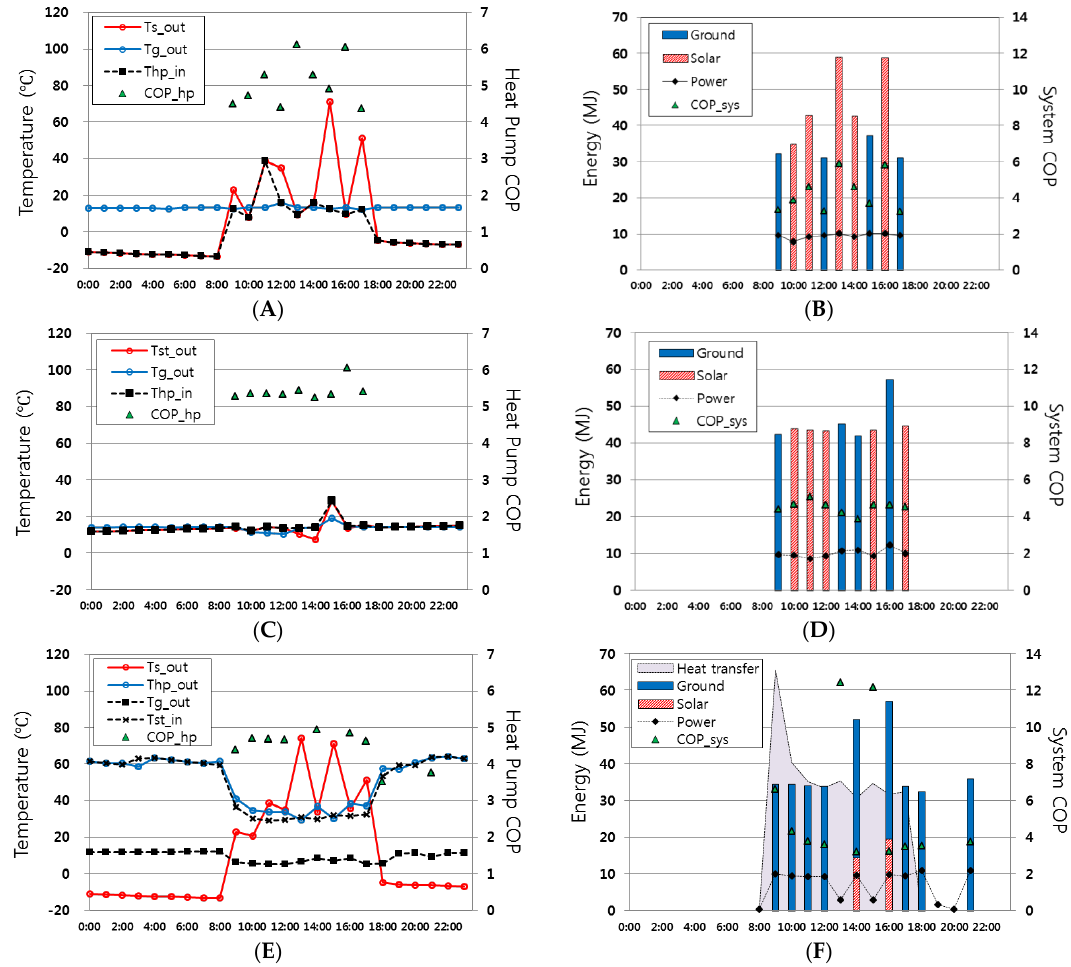
Figure 4. Simulation result of the representative day (13th January). ( A , B ) SYSTEM 1; ( C , D ) SYSTEM 2; ( E , F ) SYSTEM 3; ( A , C , E ) heat source temp. and heat pump coefficient of performance (COP); ( B , D , F ) production and system COP.